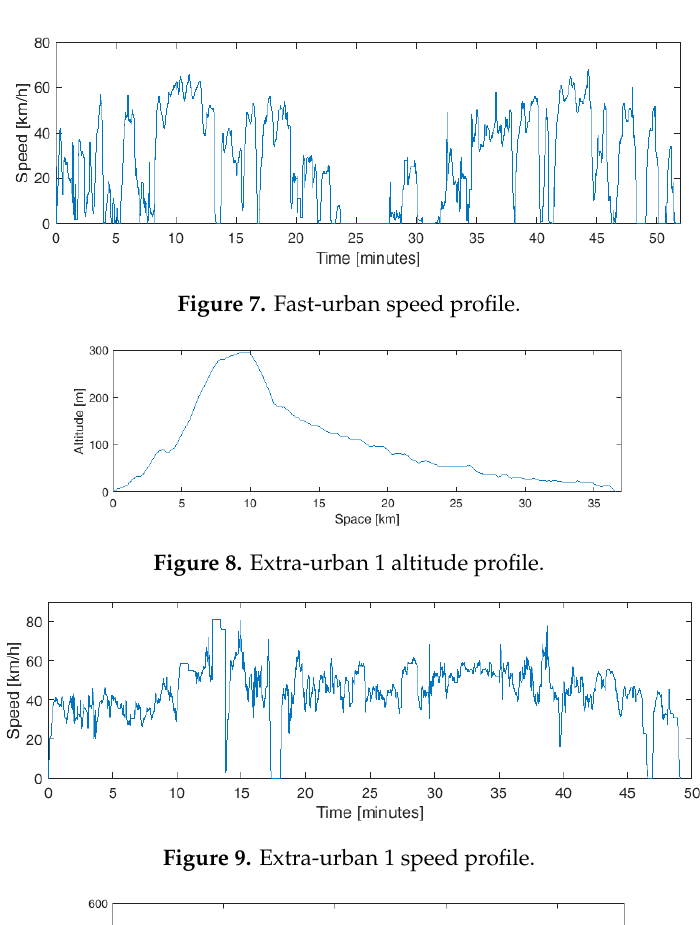
Figure 6. Fast-urban altitude profile.